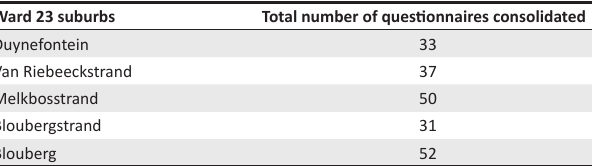
TABLE 2: Total number of questionnaires consolidated for findings.